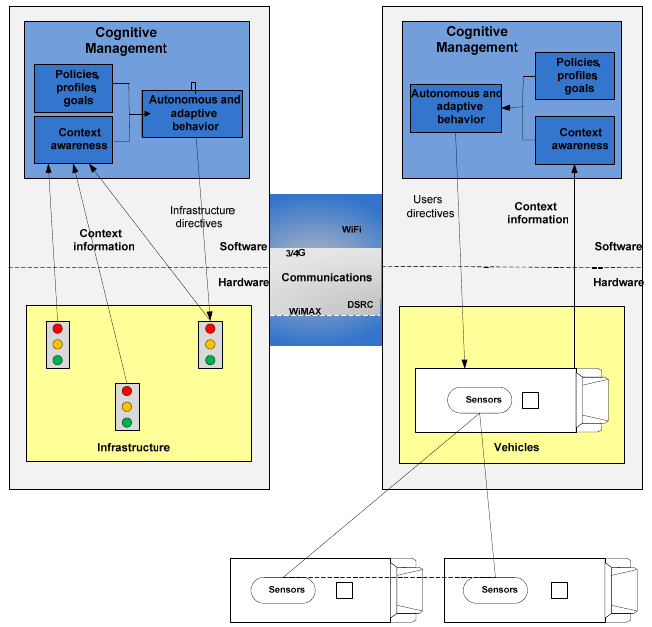
Figure 2. Concept illustration of the cognitive transport network based on the cooperation of all elements of the transport network (infrastructure, vehicles and users).